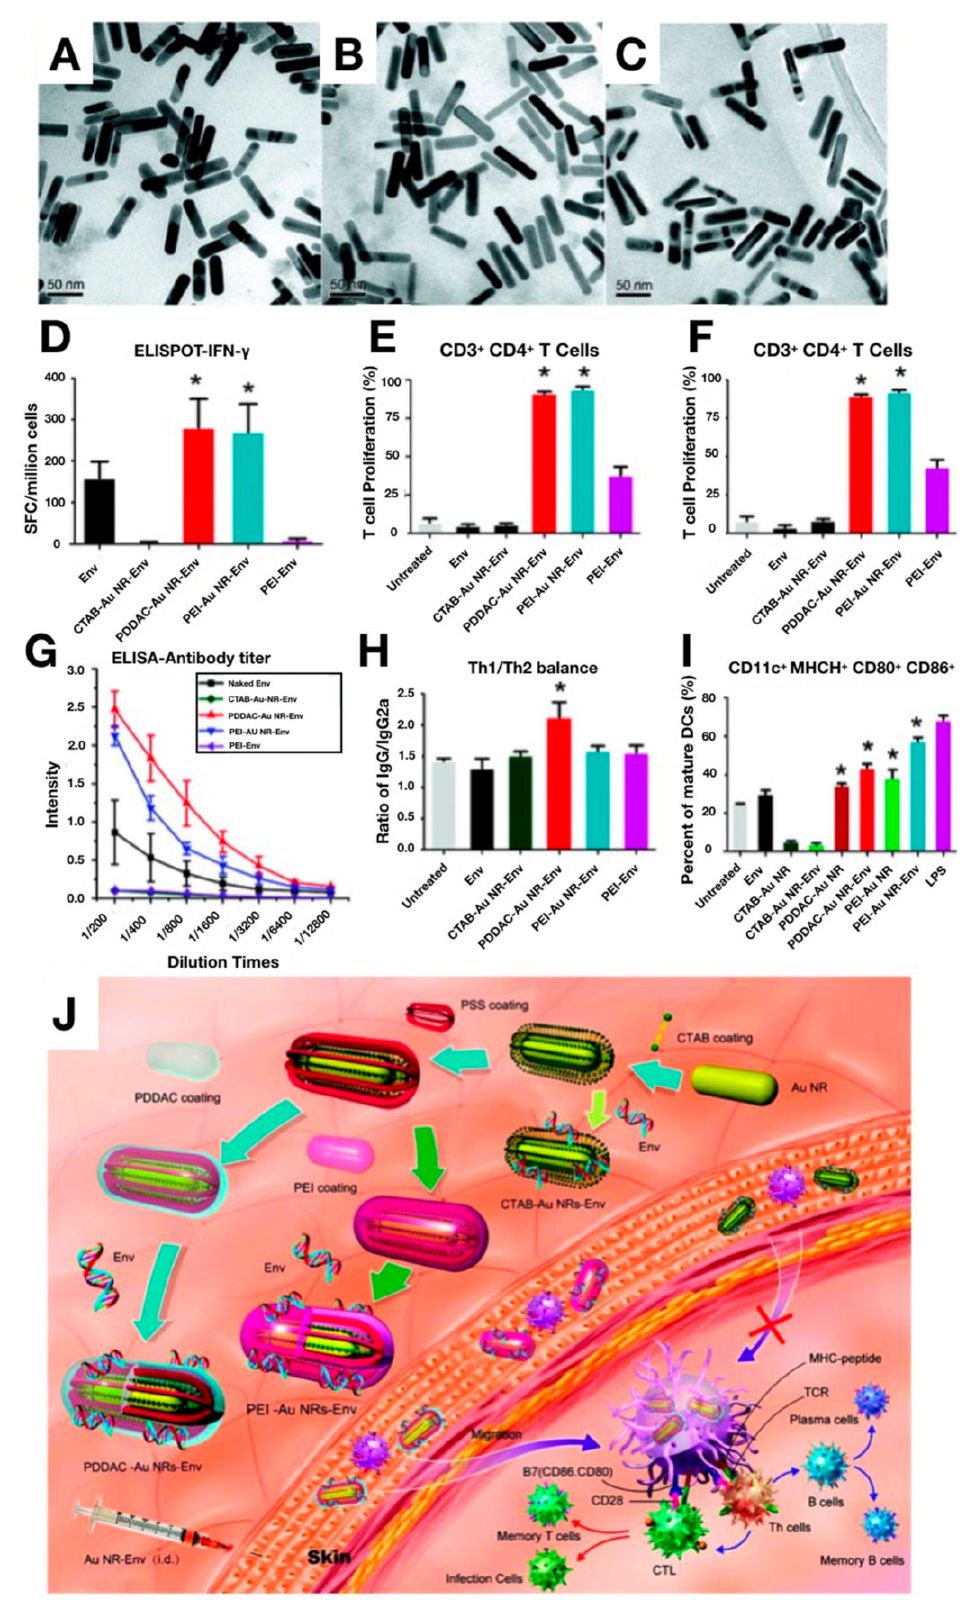
Figure 7. Gold nanorods for use as DNA vaccine adjuvants against HIV. Surface modified